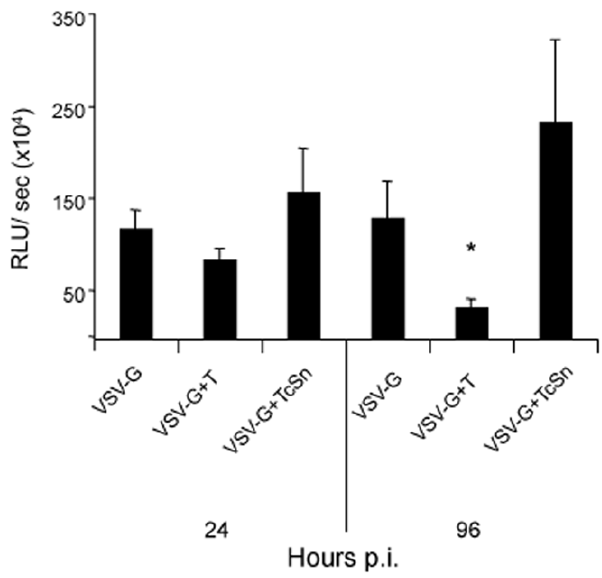
Figure 5. Effect of T.cruzi on post-integration events. MDM were infected with VSV-G pseudotyped virus overnight and kept in culture for four days. Then, they were infected with trypomastigotes or treated with TcSn overnight. Cells were lysated 24 or 96 h after parasite infection and luciferase activity was measured in cell lysates. Results are expressed as mean 6 SD of RLU/sec of triplicates of infection and a representative experiment of 3 is shown. * p , 0.01.